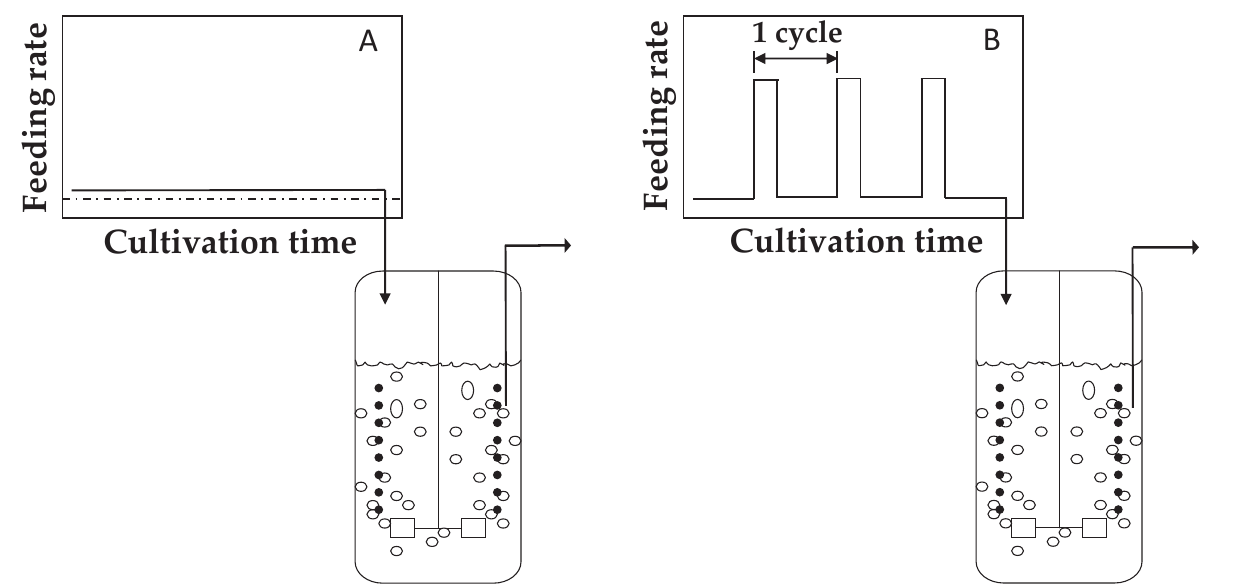
Figure 2. Scheme of the experimental setup. ( A ) Control chemostat cultures, where the culture is continuously fed and ( B ) Experimental chemostat culture, where an intermittent feeding regime (36 s feed, 324 s no feed) is